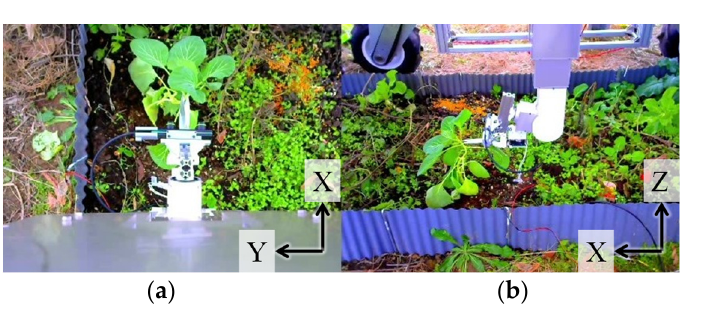
Figure 17. ( a ) Top camera, ( b ) Side camera. Comparison of environmental image correction.